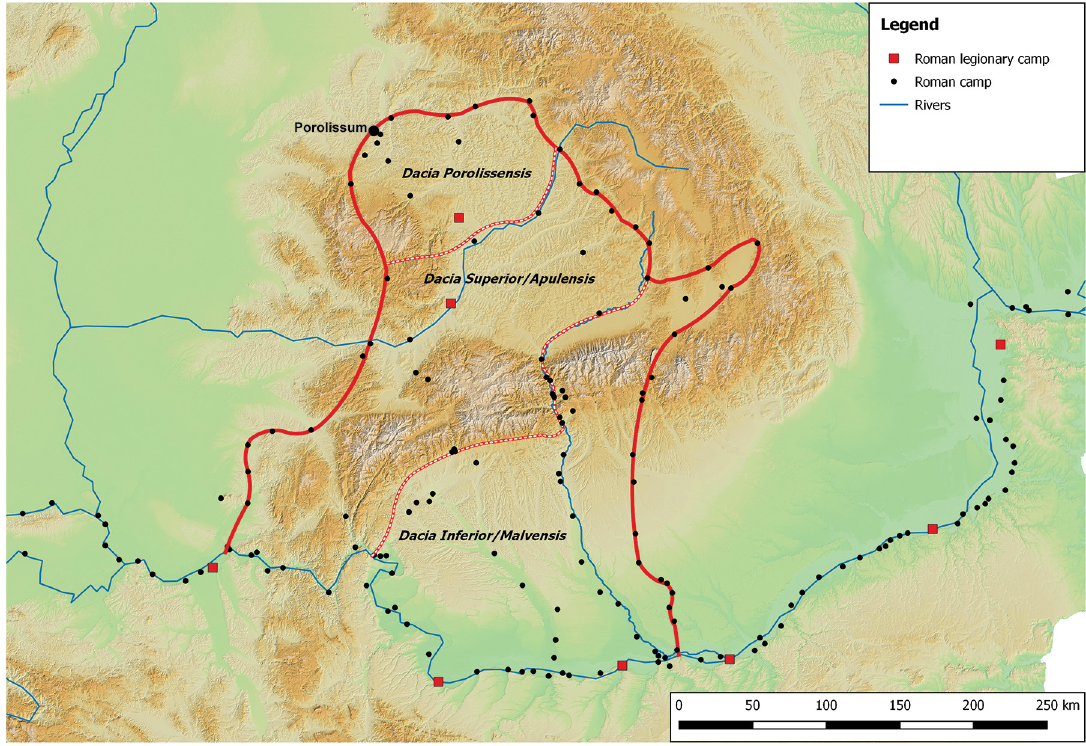
Figure 1. Map of Roman Dacia with the location of Porolissum (after Opreanu, Lăzărescu